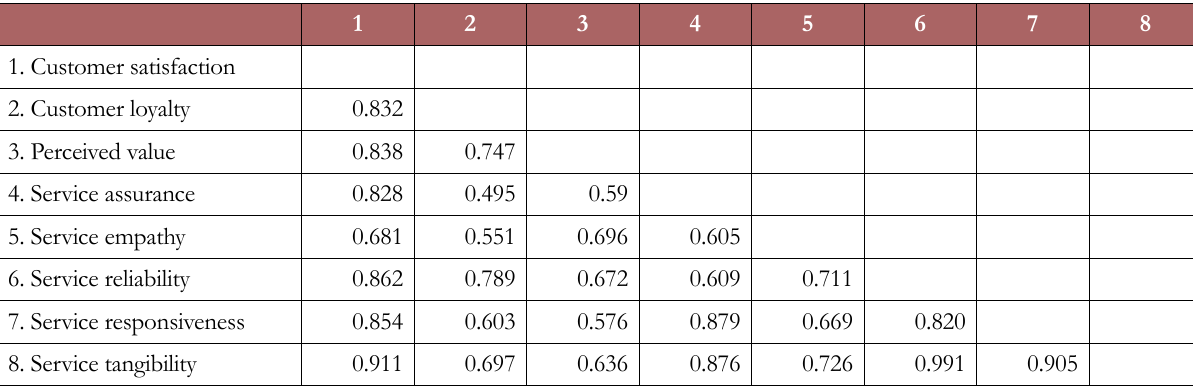
Table 3. Heterotrait-monotrait ratio of correlations